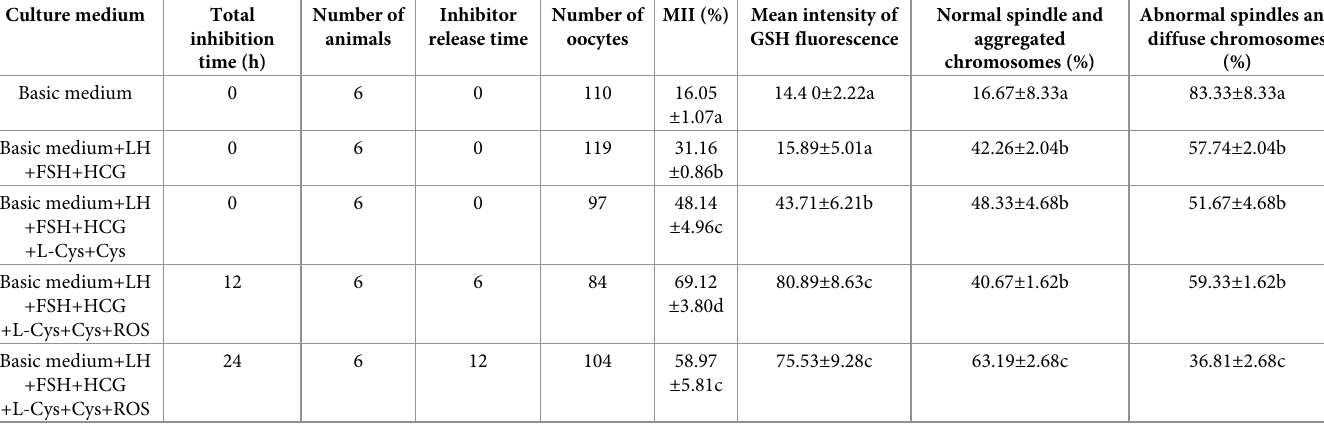
Table 8. Effects of different culture media on intracellular levels of GSH and morphology of microtubules in MII